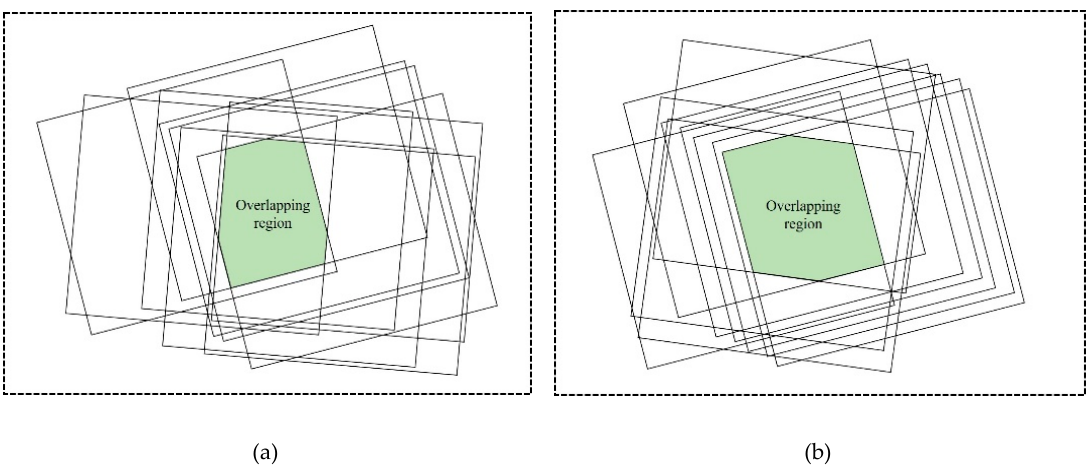
Figure 2. Spatial distribution of experimental data in ( a ) Calibration Group A (200 MHz and 24.4 µ s), and ( b ) Calibration Group B (150 MHz and 24.4 µ s).